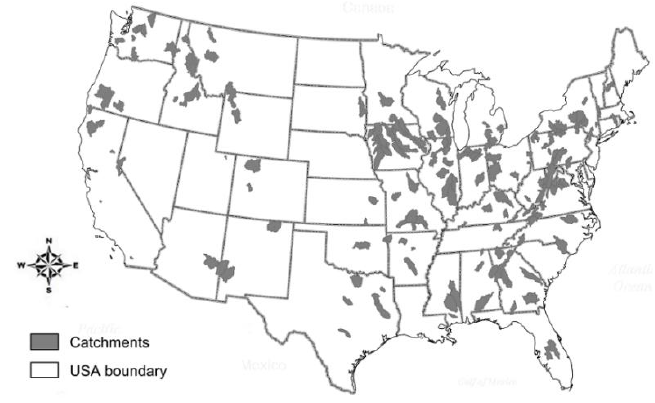
Figure 1. Locations and boundaries of 219 MOPEX catchments.